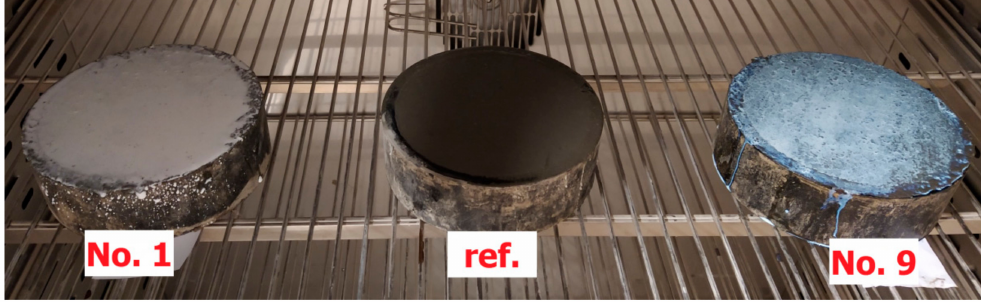
Figure 2. Samples of mortar cured in the oven (reference sample and No. 1 and